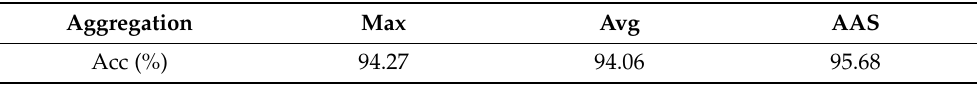
Table 6. Accuracy results (%) of different aggregation feature